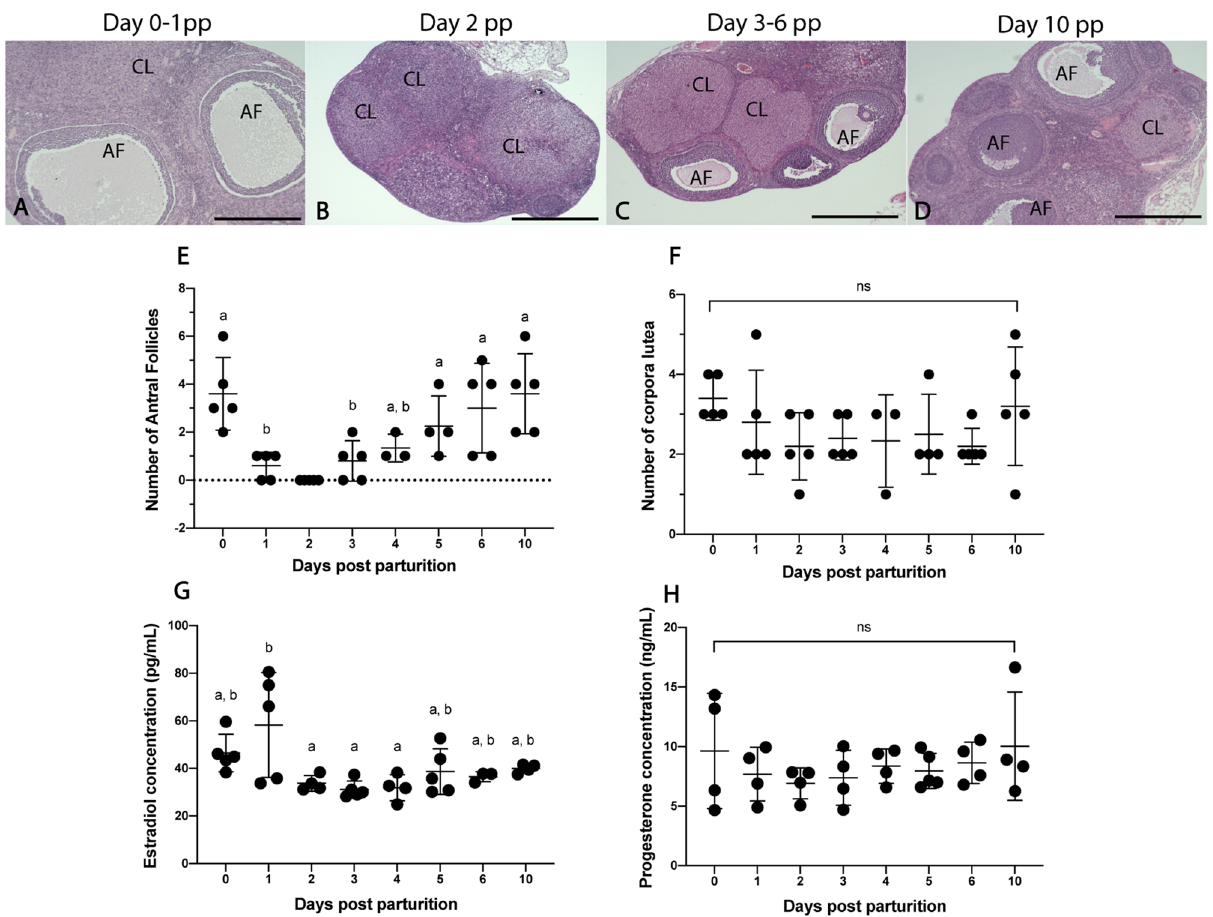
Figure 1. Comparative ovarian morphology and endocrinology between time points. Large antral follicles are present at all time points except for day 2 pp and corpora lutea are present at all time points ( A – D ). Mean antral follicle counts on days 0, 4–6 and 10 pp were similar (p > 0.05), and mean antral follicle counts on days 1, 3–4 pp were also similar (p > 0.05) ( E ). Mean number of corpora lutea was not significantly different (ns; p > 0.05) across all time points ( F ). E2 levels on days 0, 2–10 pp were similar (p > 0.05), and day 1 pp was significantly higher than days 2–4 (p < 0.05) ( G ). P4 levels were similar across all timepoints ( H ). Graphs depict mean ± SD and data with different letters (a or b) differ significantly (p < 0.05; ANOVA). Scale bars for ( A – D ) indicate 500um. AF Antral follicle, CL corpus